Question: Express in one sentence what the figure is showing.
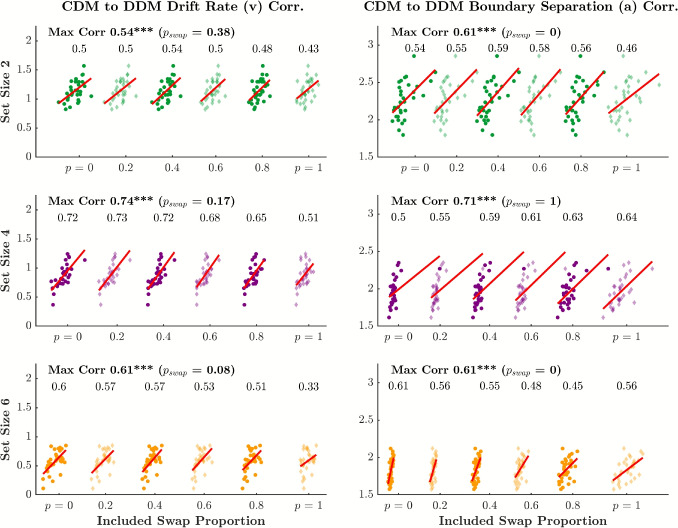
Answer: Pearson correlations between EZ diffusion model drift rate (v; left) and boundary separation (a; right) estimates from the CDM (scatter, x-axis) and DDM (scatter, y-axis) as non-parametric swap errors are increasingly substituted for recall errors on a per-participant basis (x-axis). Scatter points show parameter estimates, with best-fit regression lines overlaid on each panel. Floating values indicate correlations at discrete \documentclass[12pt]{minimal} \usepackage{amsmath} \usepackage{wasysym} \usepackage{amsfonts} \usepackage{amssymb} \usepackage{amsbsy} \usepackage{mathrsfs} \usepackage{upgreek} \setlength{\oddsidemargin}{-69pt} \begin{document}$$p_{swap}$$\end{document} = 0.2 intervals. The \documentclass[12pt]{minimal} \usepackage{amsmath} \usepackage{wasysym} \usepackage{amsfonts} \usepackage{amssymb} \usepackage{amsbsy} \usepackage{mathrsfs} \usepackage{upgreek} \setlength{\oddsidemargin}{-69pt} \begin{document}$$p_{swap}$$\end{document} at which correlations were greatest is presented atop each plot. The value of \documentclass[12pt]{minimal} \usepackage{amsmath} \usepackage{wasysym} \usepackage{amsfonts} \usepackage{amssymb} \usepackage{amsbsy} \usepackage{mathrsfs} \usepackage{upgreek} \setlength{\oddsidemargin}{-69pt} \begin{document}$$p_{swap}$$\end{document} which produces the maximum correlation is shown above each panel